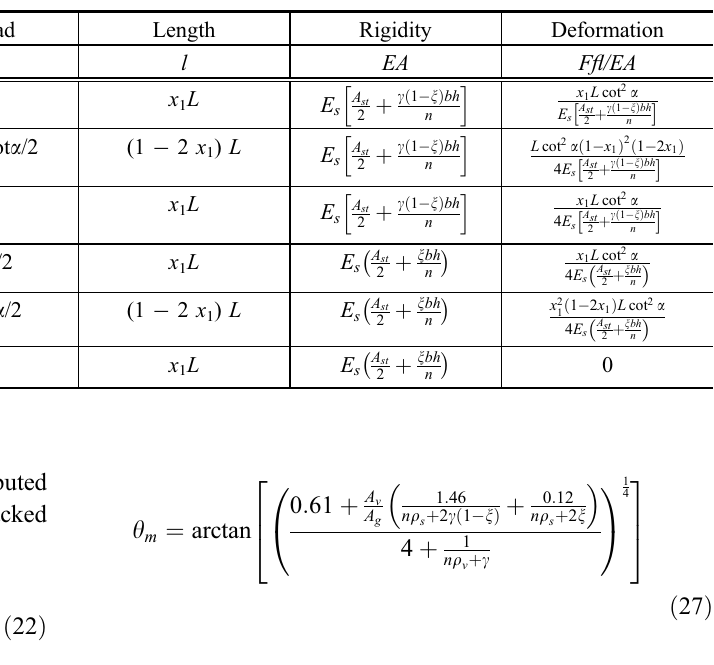
Table 3 Chord deformations of VATM by two-point Gauss